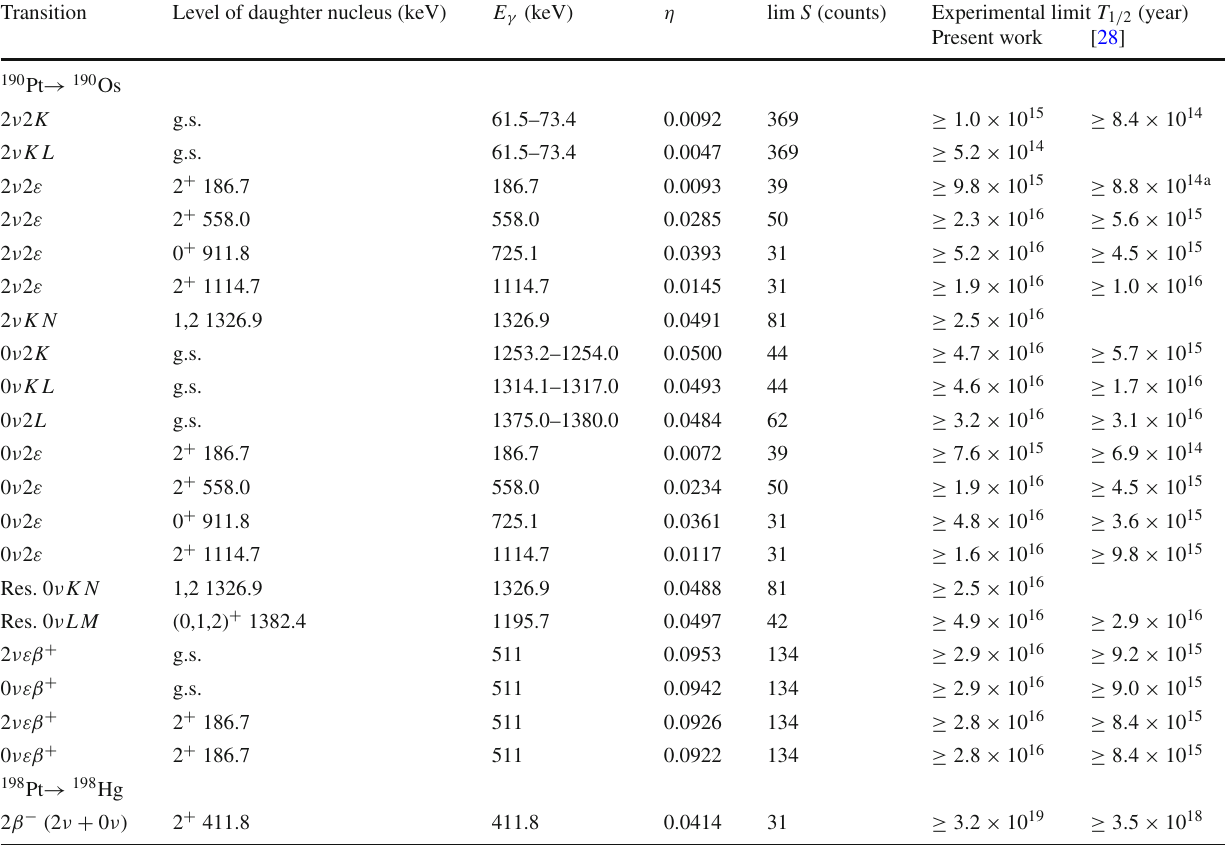
lim S .Theresultsofpreviousexperiment[28]aregivenforcomparison. Values of lim S and T 1 / 2 are given at 90% C.L. All the empirical fits from which the signal upper limits are derived describe the data well, with the goodness-of-fit values within χ 2 /n.d.f. =